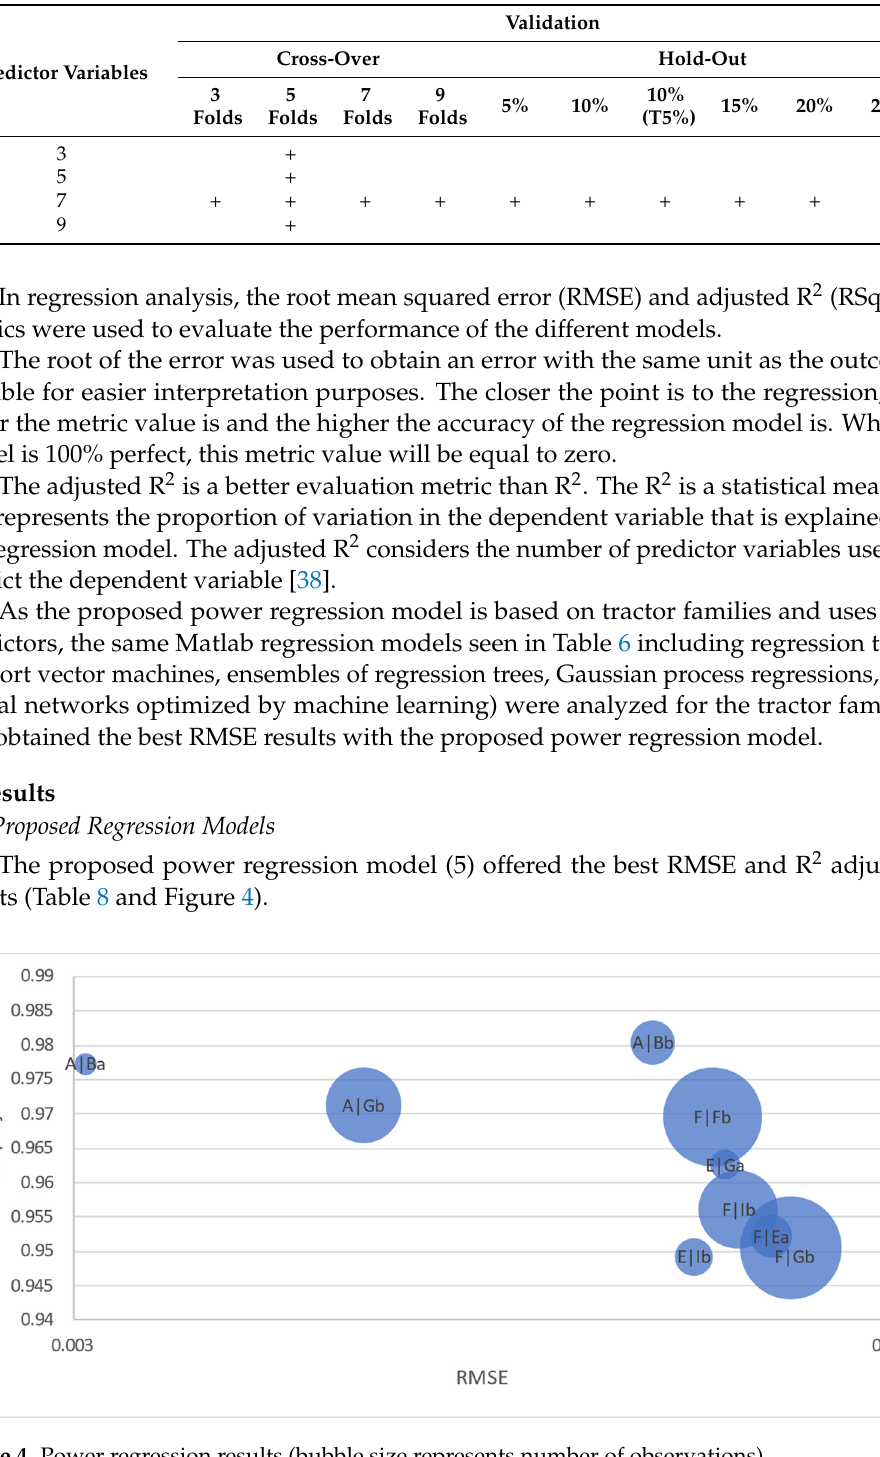
Table 7. Number of predicting variables and validations evaluated.